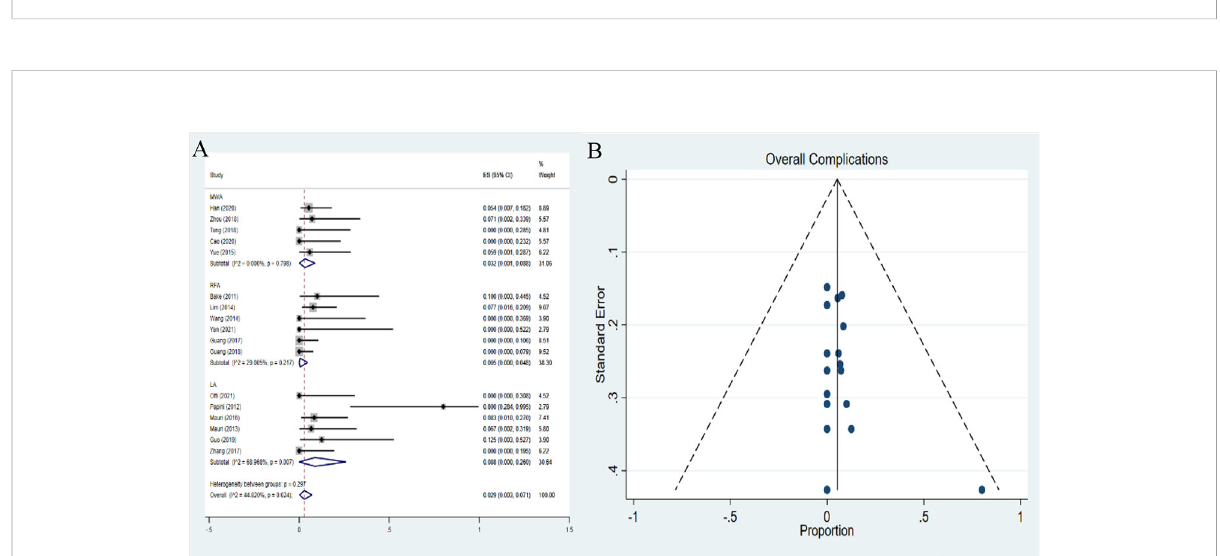
FIGURE 9 Forest plots (A) and funnel plots (B) of pooled overall